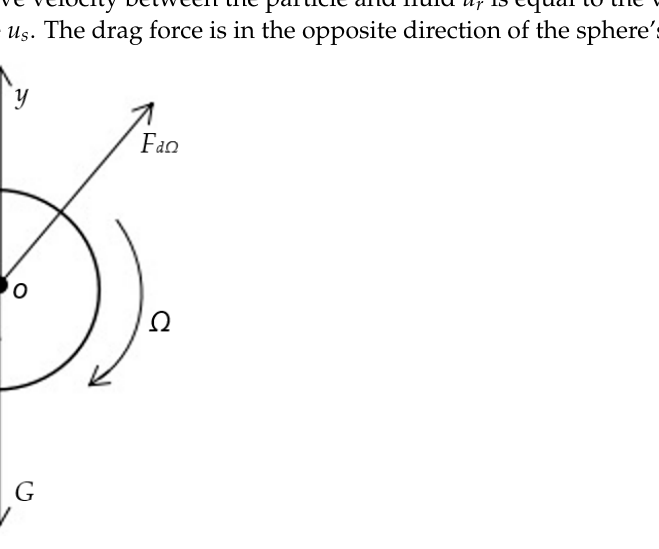
Figure 4. Schematic diagram of the coordinate system and forces acting on a spinning sphere.